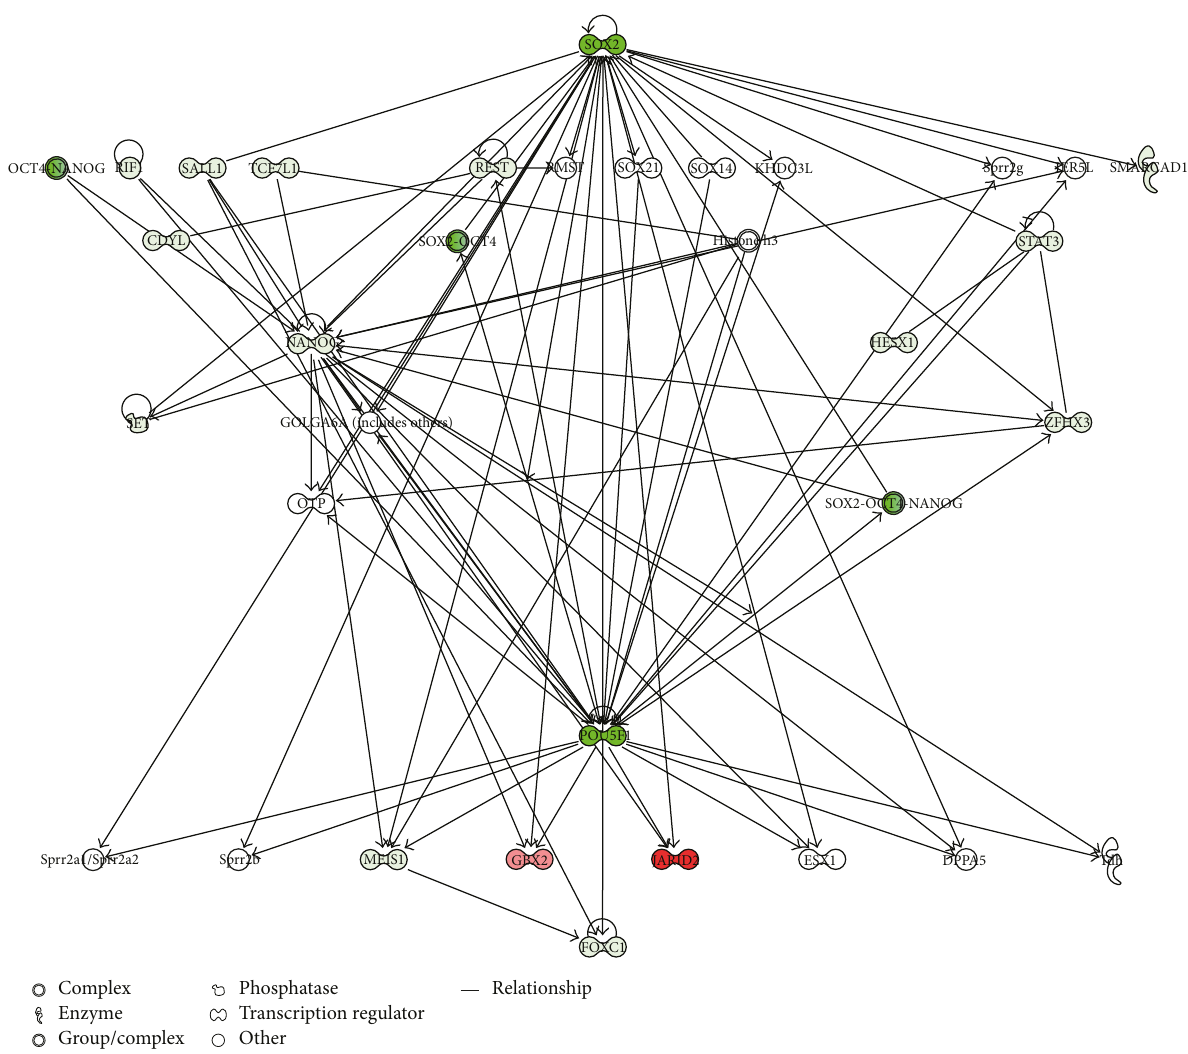
Figure 8: Gene modulation of hDPSCs. IPA-inferred cluster analysis of the hDPSC dataset of signi fi cantly expressed genes at